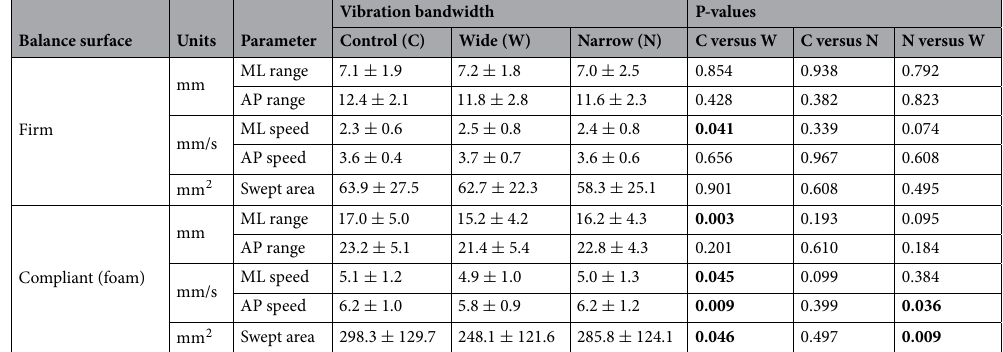
Table 1. COP sway parameters (mean ± SD) for firm and compliant surface balance trials with different mechanical noise bandwidths introduced.